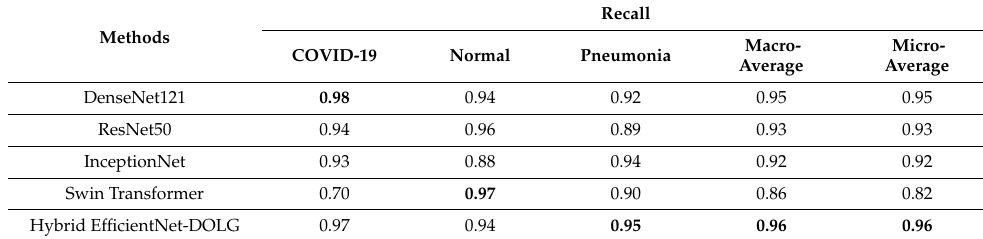
Table 5. Comparing results between the five deep learning models on the COVID-19 classification task with respect to recall metric.